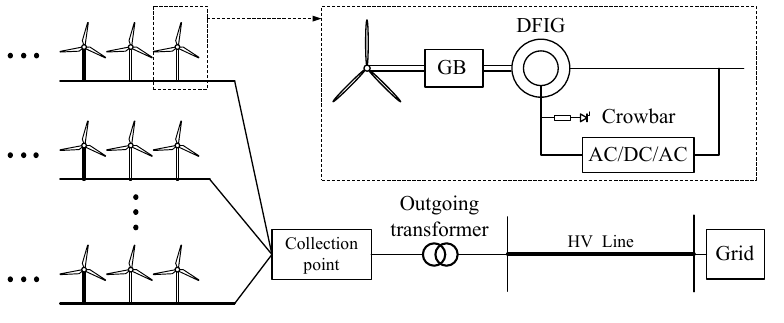
Figure 1. Structure of a typical large-scale doubly fed induction generator-based wind farm integrated with a power